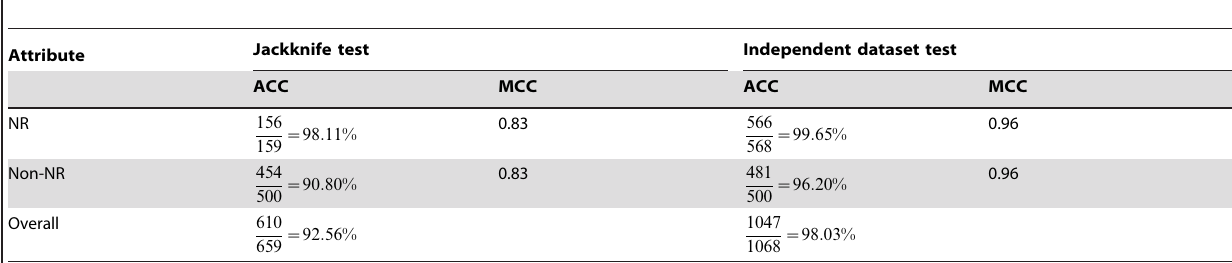
Table 2 . Prediction success rate and MCC index in identifying NR and non-NR by the jackknife test and independent dataset test.